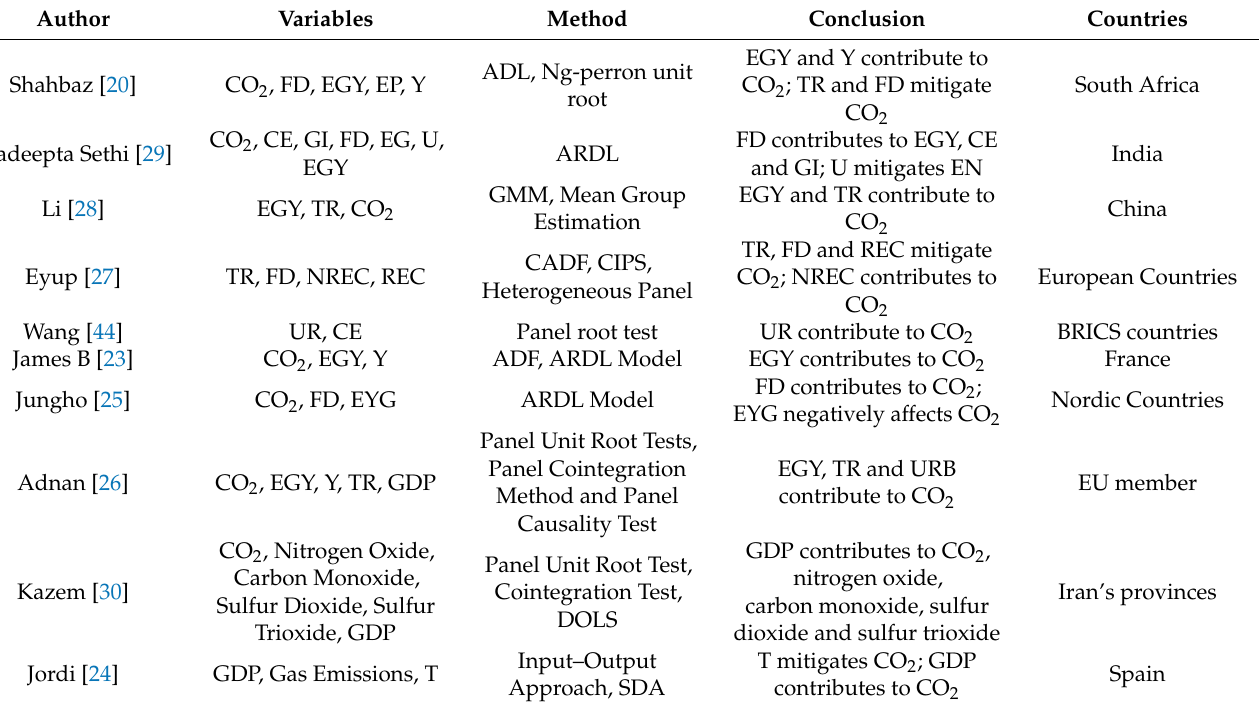
Table 1. Survey of different research studying the relationship between financial development and carbon dioxide